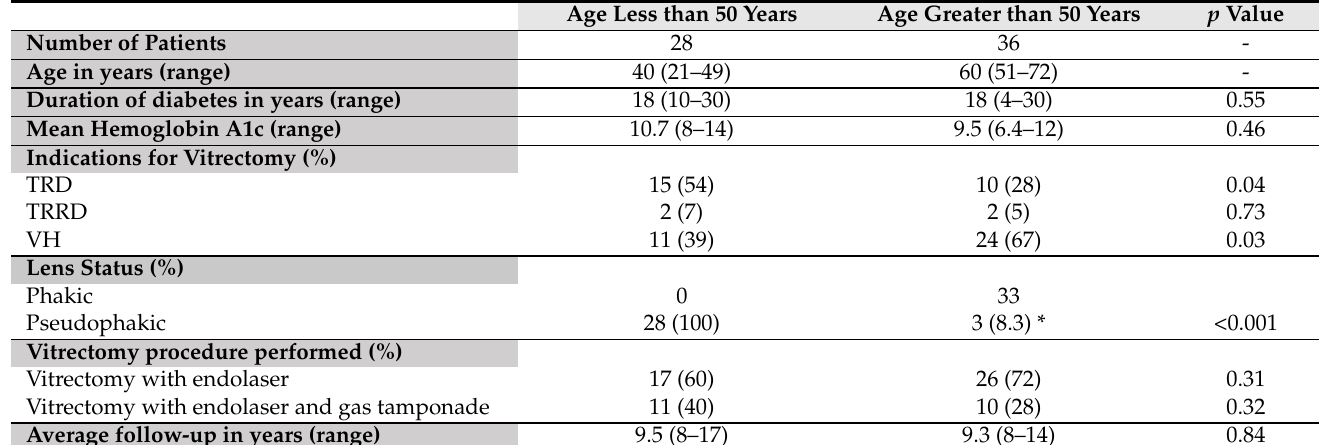
Table 1. Patient